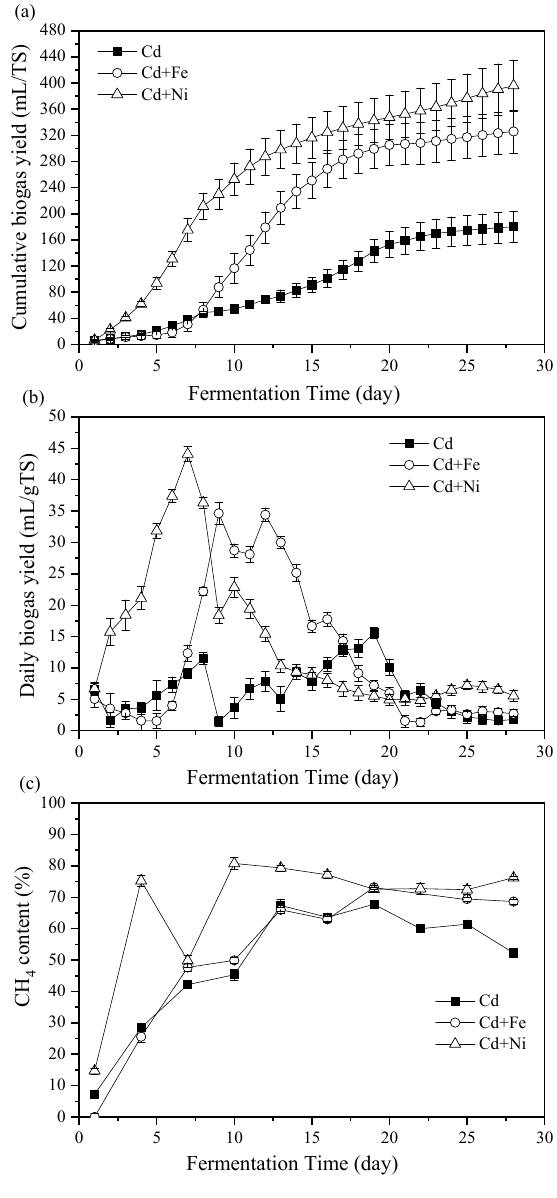
Figure 1. Cumulative biogas yields ( a ), daily biogas yield ( b ), and CH 4 contents ( c ) in response to Cd, Cd + Fe, and Cd + Ni addition during the fermentation.